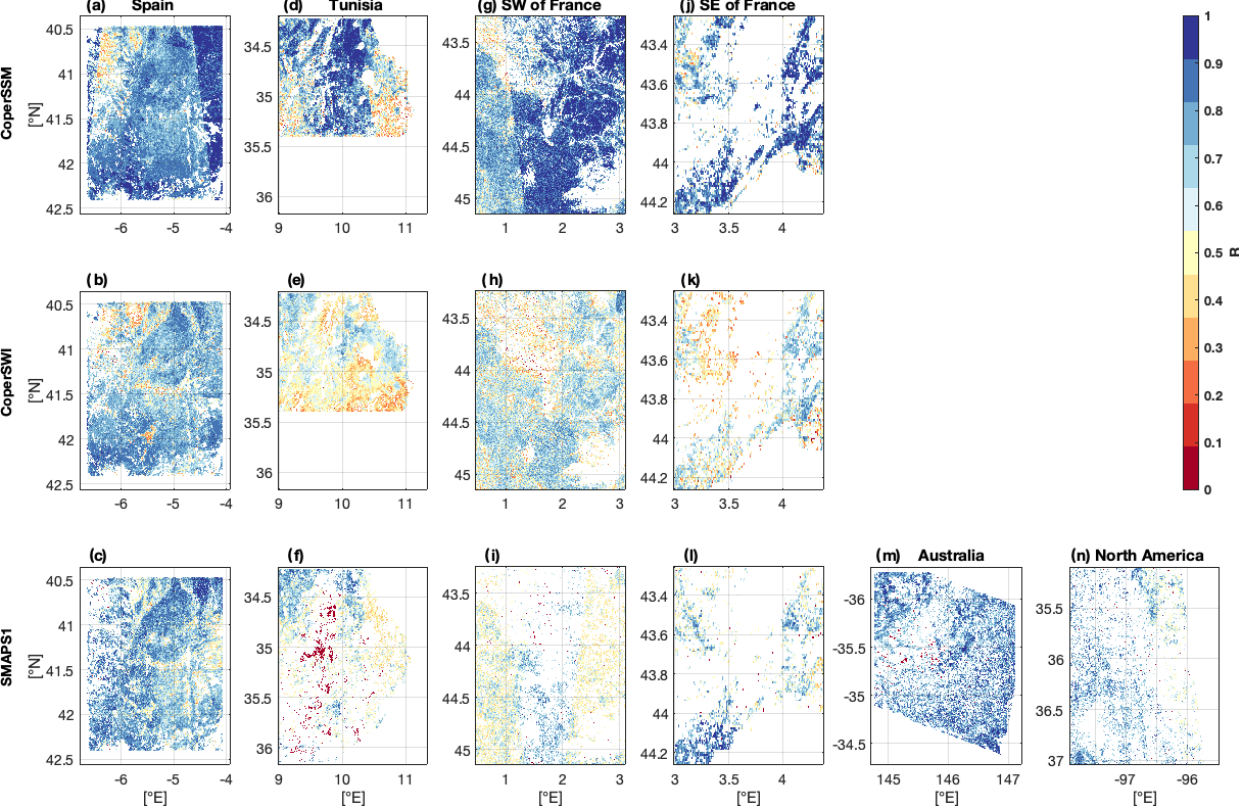
Figure 7. Comparison of S 2 MP S1S3 with respect to CoperSSM, CoperSWI, and SMAPS1 over the regions of study in terms of Pearson correlation ( R ). The analysis was performed from January to December